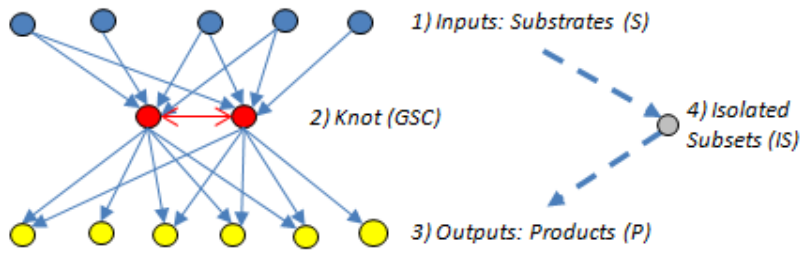
Figure 9. A simplified example of a bow